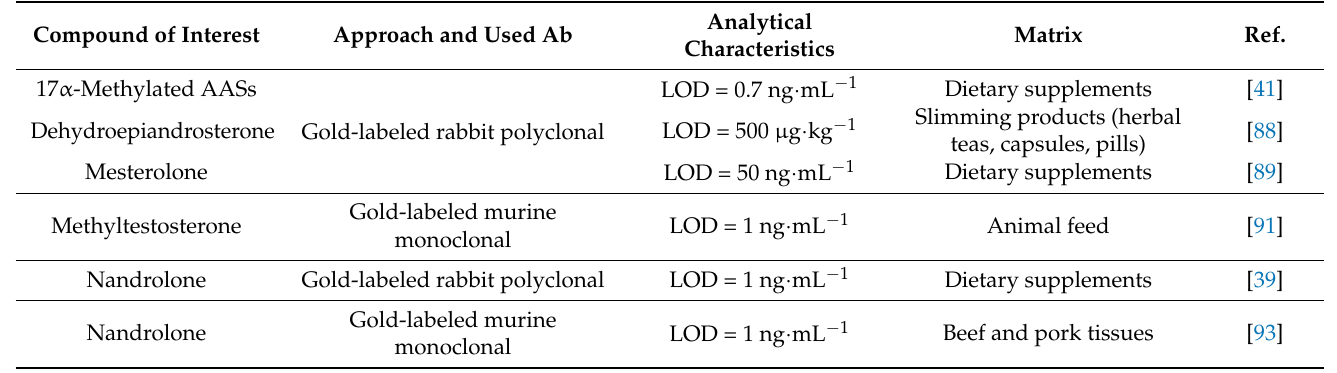
Table 3. Lateral flow immunoassays (LFIAs) for the determination of anabolic-androgenic